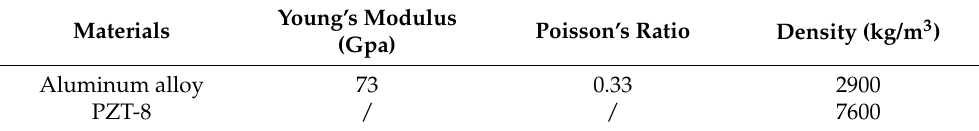
Table 1. Mechanical properties of the materials.